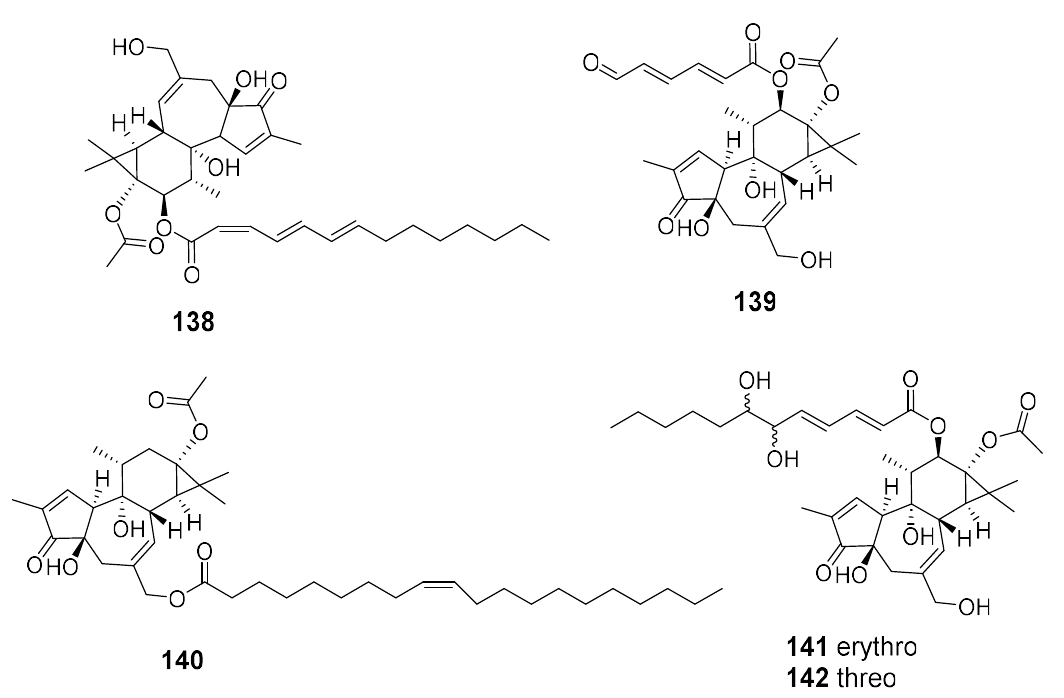
Figure 8. Structures of tirucallane triterpenoids from Aquilaria sinensis. Molecules 2018 , 23 , x